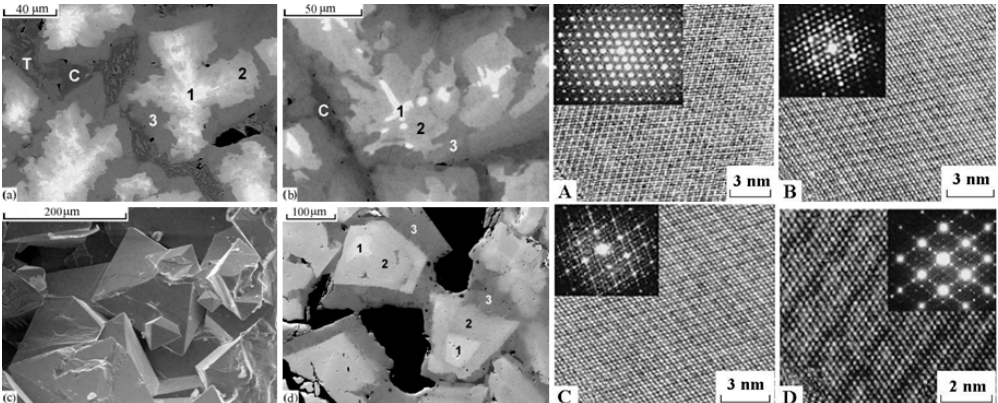
Figure 5. Left: SEM images of ceramics with 10% ( a ) UO 2 , ( b ) PuO 2 , ( c , d ) ThO 2 . (1) murataite 5C, (2) murataite 8C, (3) murataite 3C, (C) crichtonite, (T) pyrophanite; pores are black. Right: HRTEM micrographs of ( A ) pyrochlore, murataite ( B ) 3C, ( C ) 5C, ( D ) 8C taken with a high-resolution transmission electron microscope. Inserts: SAED patterns. Lines are atomic layers.